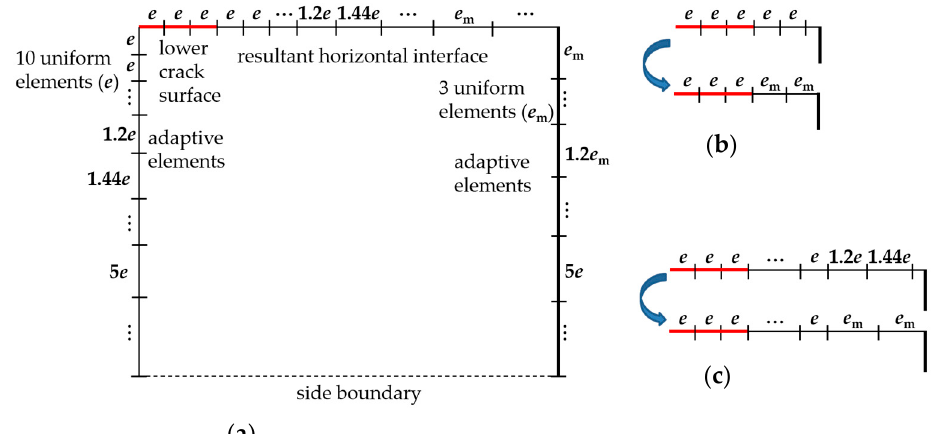
Figure 4. Schematic view of ( a ) discretization of the lower part of the top layer; ( b ) treatment of the elements adjacent to the corner when the horizontal interface is short; and ( c ) treatment of the elements adjacent to the corner when the horizontal interface is long.